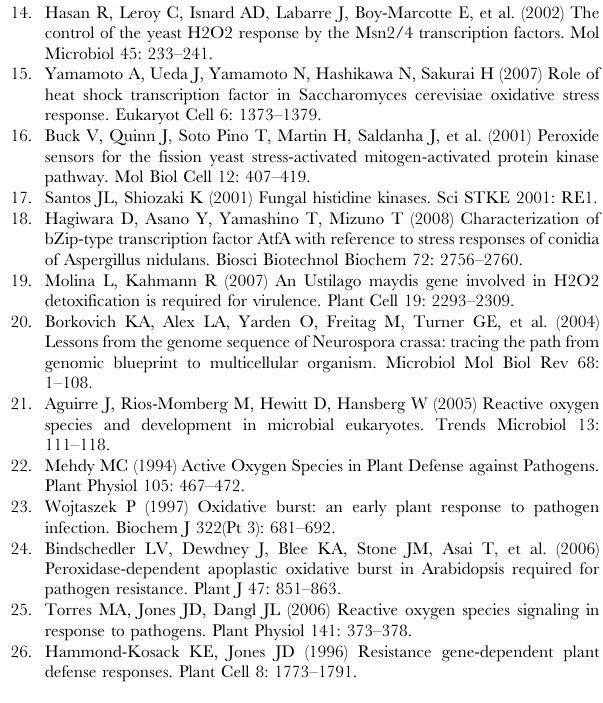
Table S1 Primer sequences used in this study. Found at: doi:10.1371/journal.ppat.1000653.s008 (0.02 MB